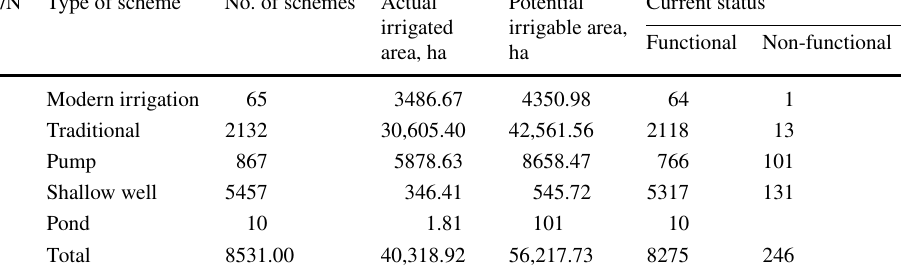
Table 12 Potential and actual irrigated area in the West Shewa